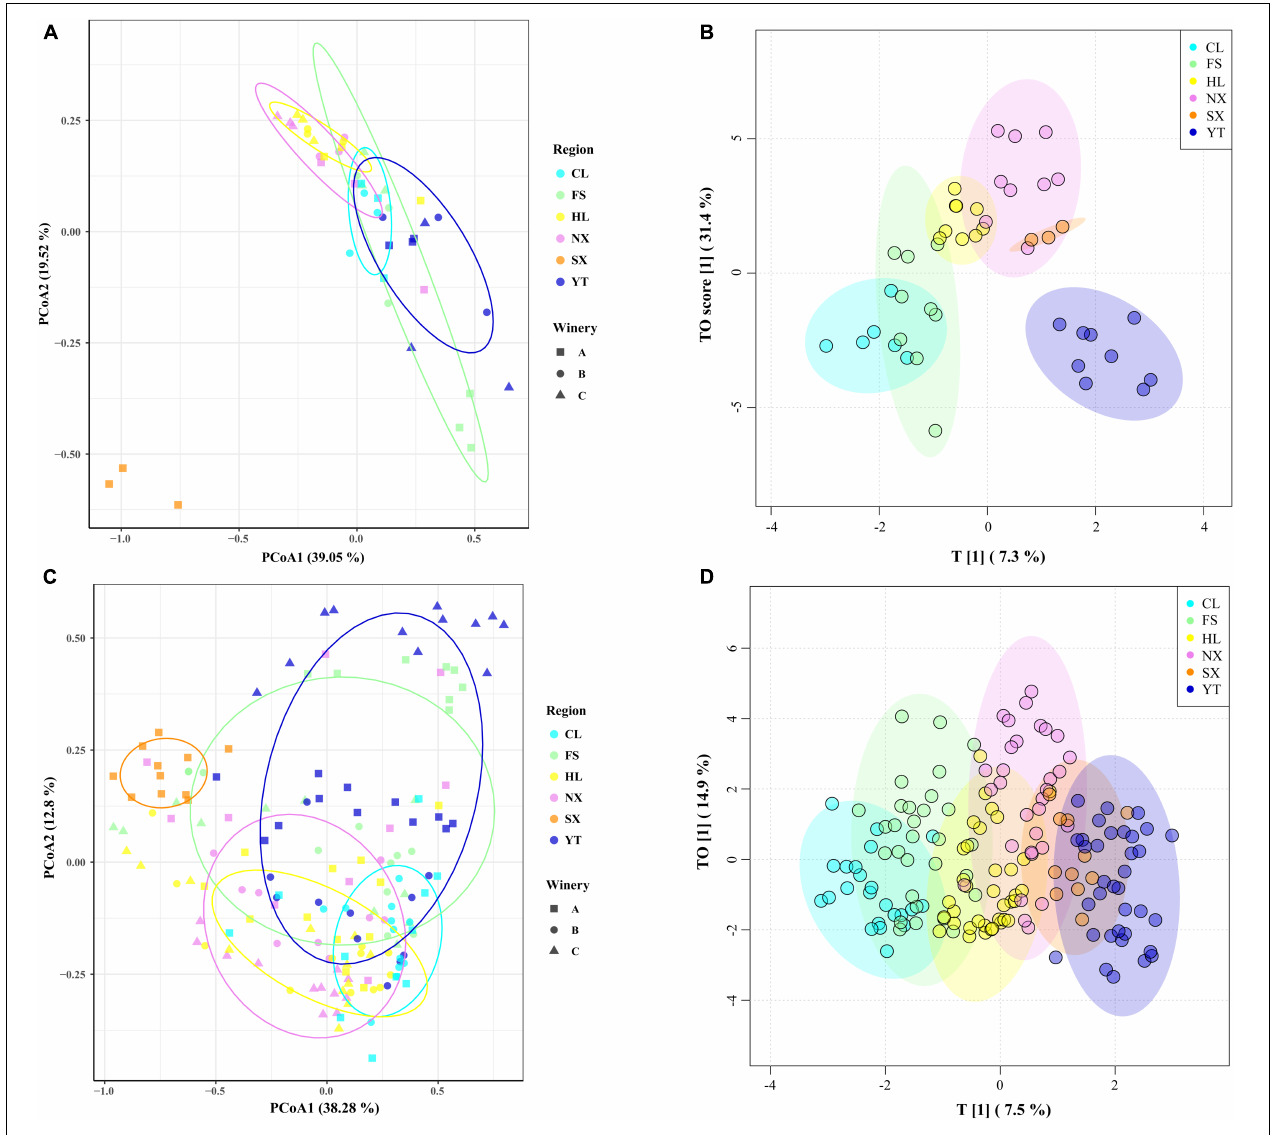
FIGURE 3 | Coordinate and cluster analysis of the Marselan must fungal communities of different regions and wineries. (A) Weighted UniFrac PCoA plot of the Marselan must fungal communities. (B) OPLS-DA plot of the Marselan must fungal communities. (C) Weighted UniFrac PCoA plot of the Marselan fermented sample fungal communities. (D) OPLS-DA plot of the Marselan fermented sample fungal communities. Different colors correspond to different regions, and different shapes correspond to different wineries within a